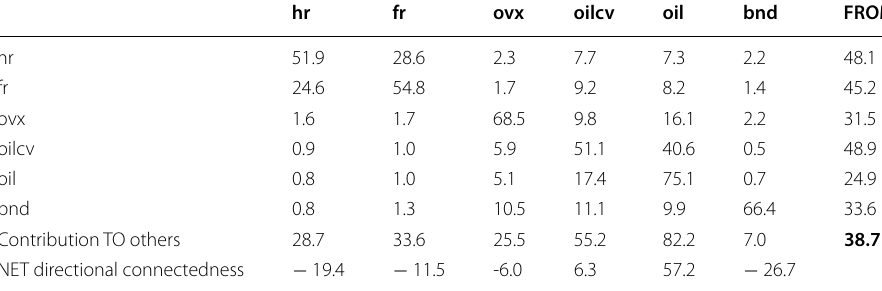
Table 5 System connectedness evaluated at the median (τ